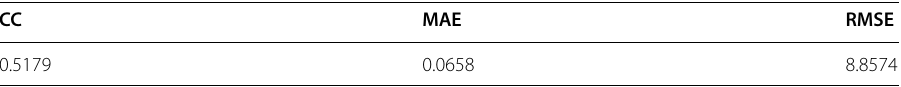
Table 9 Evaluation of the prediction model